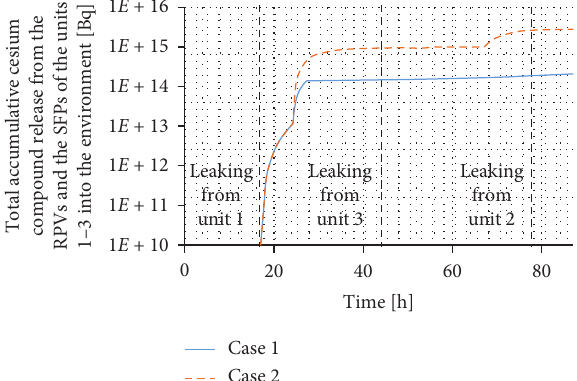
Figure 14: Total accumulative release of cesium compounds into the environment from Units 1–3 estimated by Modified ART Mod 2 of case 2 comparing to the reference case. Table 7: Deposition phenomena of CsI gas in the SFP and the RB of Units 1 and 3 of the second case simulated by Modified ART Mod 2. Unit